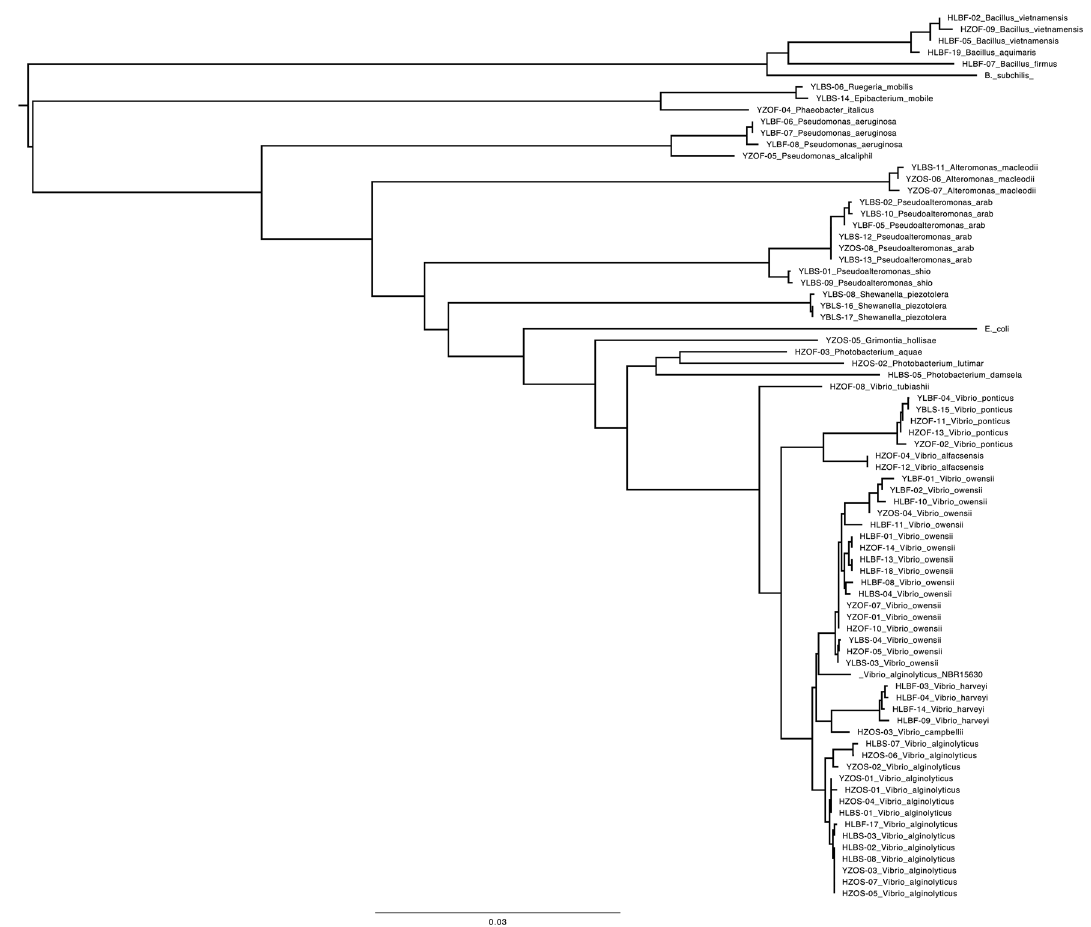
Figure 4. Phylogeny of isolated bacteria from Andamia tetradactylus and Entomacrodus stellifer . The 35 and 40 strains were isolated from A. tetradactylus and E. stellifer, respectively.16S rDNA of those strains were amplified by PCR and determined by sequencing. Based on those sequences, the phylogenetic tree was constructed by the ClustalW program (DDBJ,